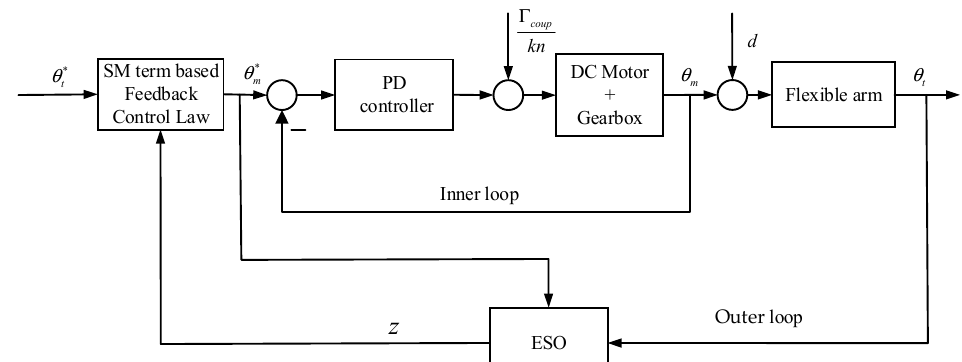
Figure 2. General control scheme.